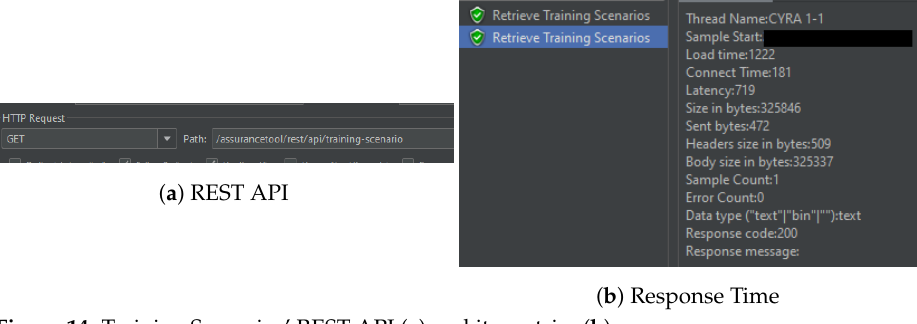
Figure 14. Training Scenarios’ REST API ( a ) and its metrics ( b